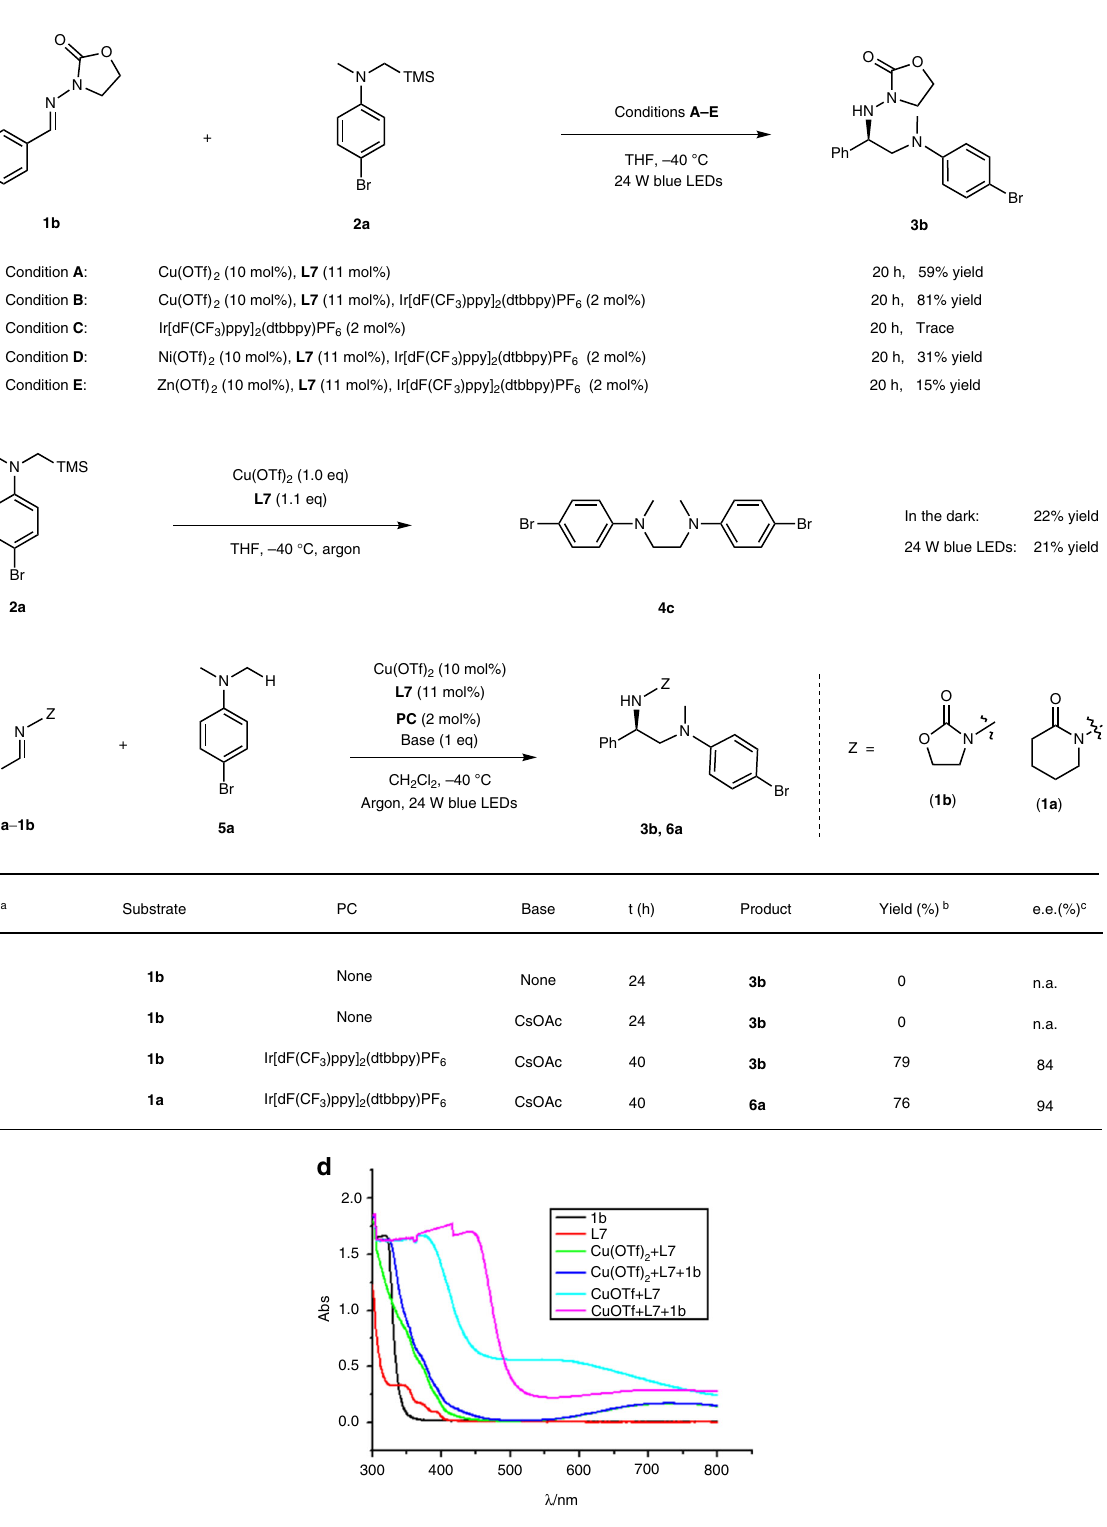
Fig. 5 Probing the functions of the chiral copper catalyst. a Evidence for Lewis acid activation. b Evidence for single electron oxidation. c Evidence for powerful stereocontrol. a Reaction conditions: 1b or 1a (0.20 mmol), 5a (0.60 mmol), Cu(OTf) 2 (10 mol%), L7 (11 mol%), CH 2 Cl 2 (2.0 mL), − 40 °C, 24 W blue LEDs, under argon. b Isolated yield. c e.e. value determined by chiral HPLC. d Evidence for the potential photoactivity of copper(I)